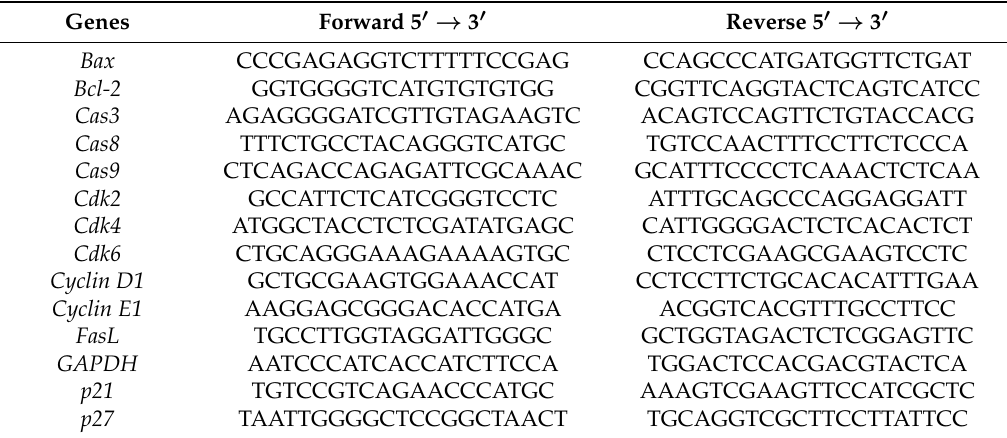
Table 1. qRT-PCR primer